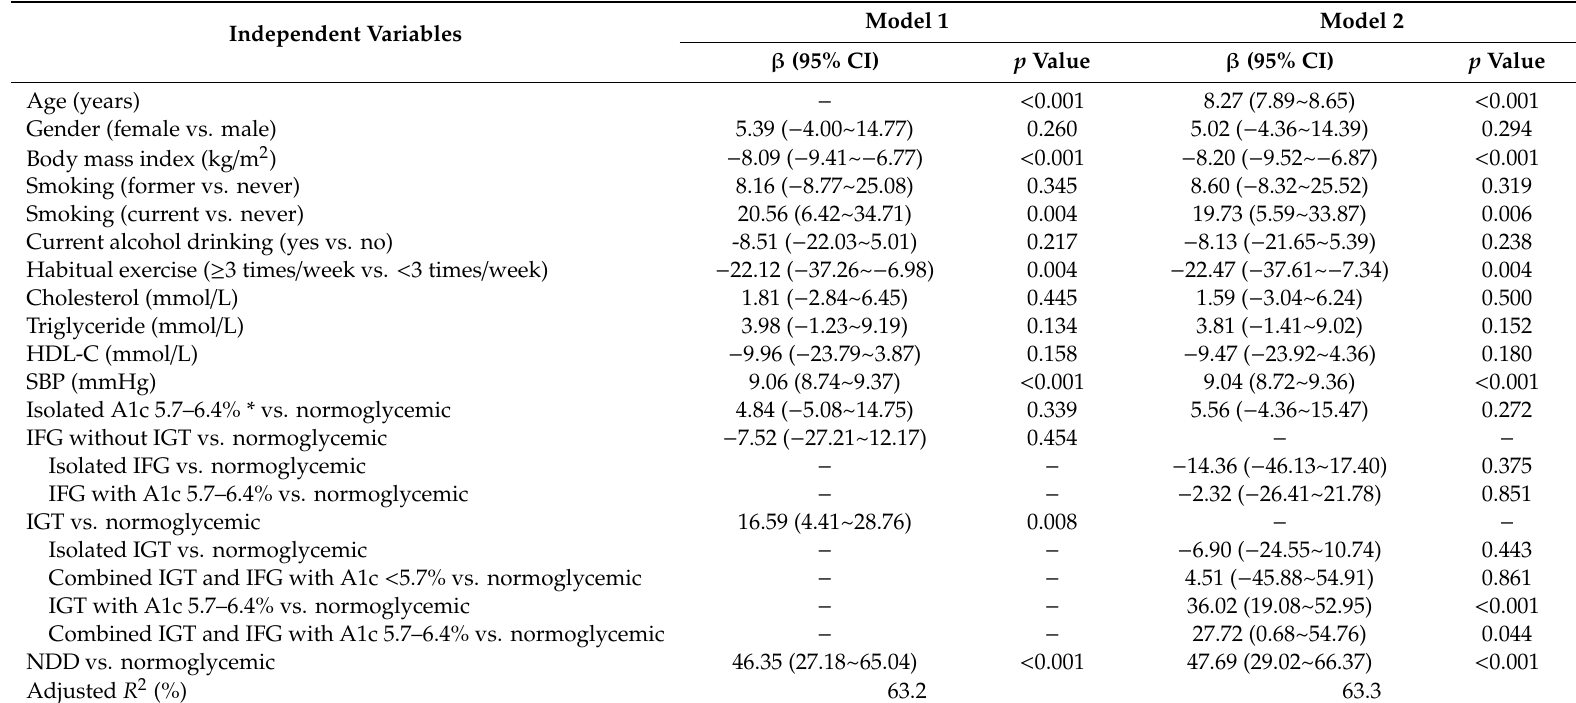
Table 2. Coe ffi cients ( β ) and 95% confidence intervals (CI) for the independent e ff ects of clinical variables on baPWV level. Independent